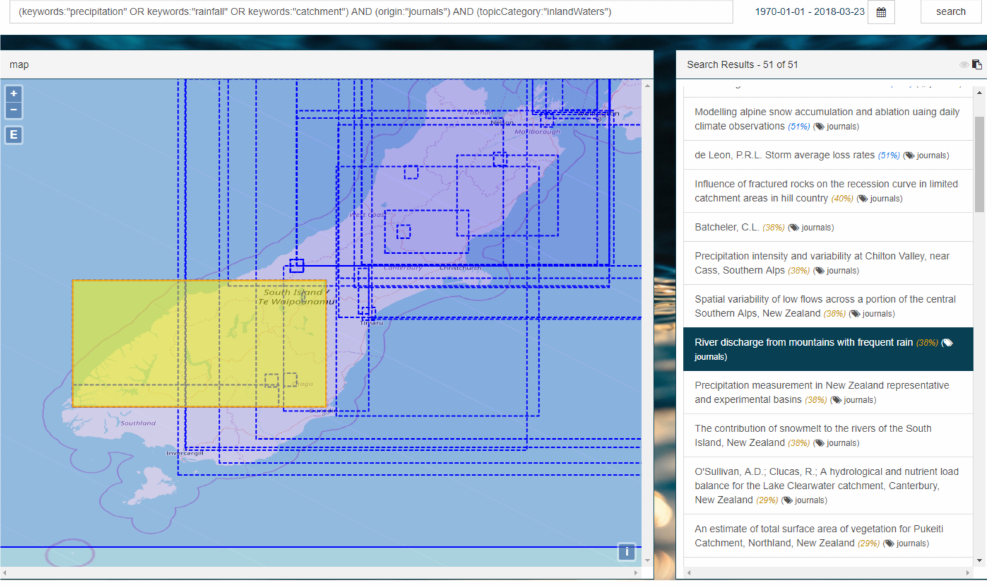
Figure 4. The search form of the implemented web application. Besides the textual parameters or keywords, the bounding box of the map on the left is used as a spatial constraint for the metadata